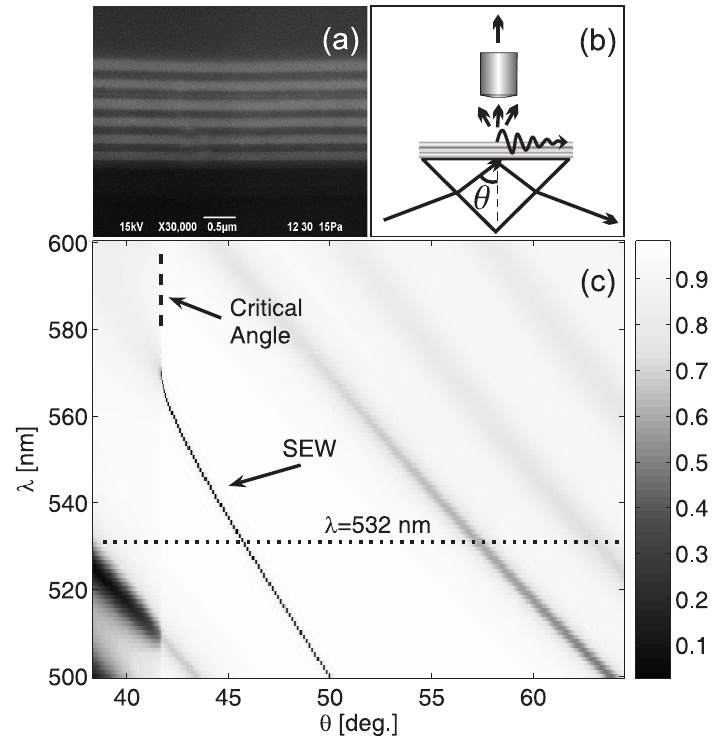
Figure 1. ( a ) Typical SEM image of one-dimensional photonic crystal, consisting of 6 SiO 2 /Ta 2 O 5 bilayers at the quartz substrate (from bottom to top); ( b ) Schematic of the Kretschmann configuration for the Bloch surface waves (BSW) coupling and detection; ( c ) Calculated normalized reflectivity map R( θ , λ ) of the 1D photonic crystal illuminated in the Kretschmann configuration. Darker regions indicate lower reflectance. BSW dispersion curve is indicated by the arrow and SEW acronym. Reprinted with permission from I.V. Soboleva, E. Descrovi, L. Dominici, F. Michelotti, F. Giorgis, A.A. Fedyanin, Proceedings of SPIE 7356, 73560E (2009)